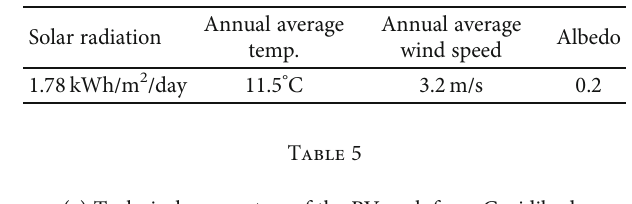
(a) Technical parameters of the PV park from Grojdibodu